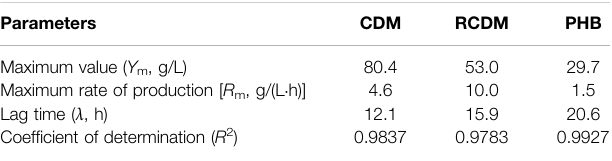
TABLE 5 | Kinetic parameters for CDM, RCDM, and PHB productions predicted by modi fi ed Gompertz model ( Eq. 1 ). Parameters